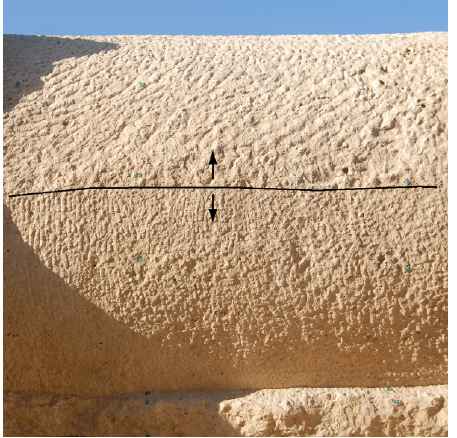
Figure 8. North-south continuance sections of the column